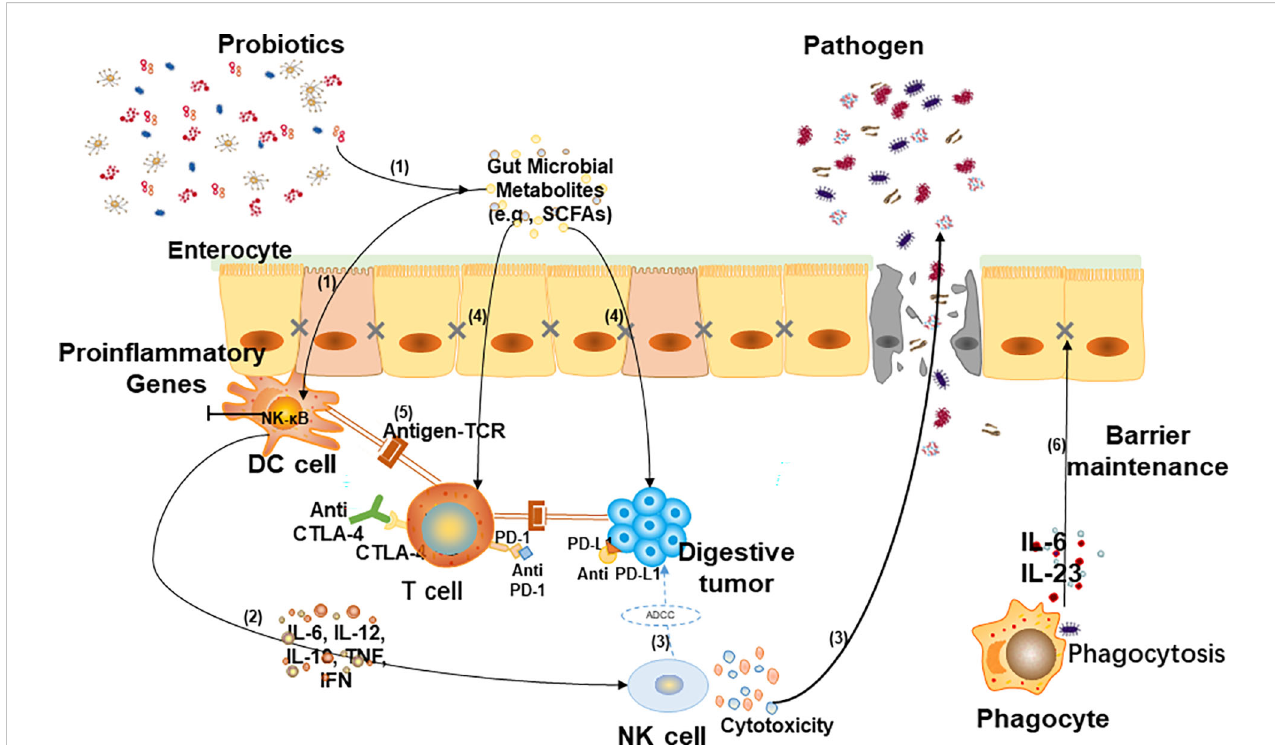
FIGURE 2 Relationship between gut microbiota and digestive cancer immunotherapy. (1) When tumors arise, gut fl ora and its metabolites (such as short-chain fatty acids) activate dendritic (DC) cells. (2) Cytokines are involved in activating NK cells and promoting the migration of NK cells to tumor sites. (3) Killer (NK) cells can directly kill tumor cells via antibody-dependent cellular cytotoxicity (ADCC) and inhibit pathogenicity through cytotoxicity. (4) Some metabolites shape the immune system by regulating T cell differentiation and also participate in tumor-killing by interacting with host cell surface receptors. (5) Anti- cytotoxic T lymphocyte-associated antigen-4 (CTLA-4) enhance the interaction between DC cells and T cells, and anti-programmed cell death ligand 1 (PD-L1) stimulate T cell immune response to promote immunotherapy. (6) Phagocytes eliminate pathogens by phagocytosis and secret cytokines to recover intestinal barrier